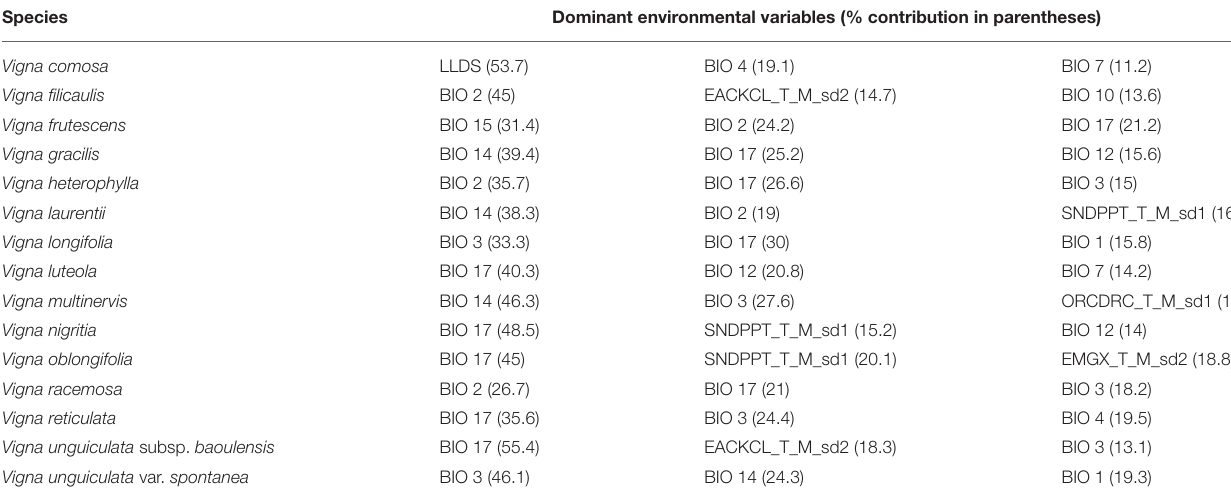
TABLE 2 | The top three dominant environmental factors affecting the distribution of 15 Vigna CWR taxa in Benin.